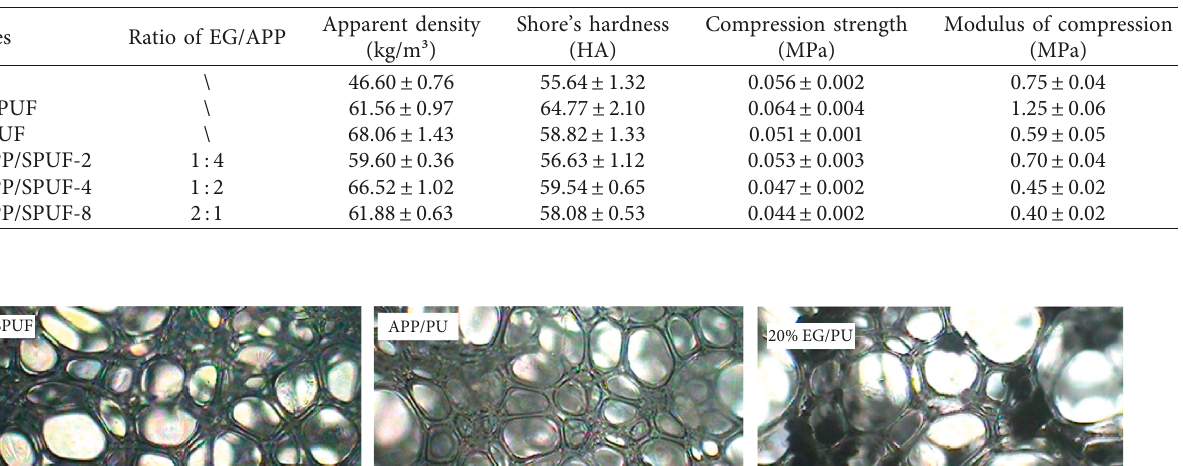
Figure 2: SEM micrograph of SPUF composites’ char residue obtained from LOI test. Table 4: Influence of EG/APP proportion on the performances of SPUF.